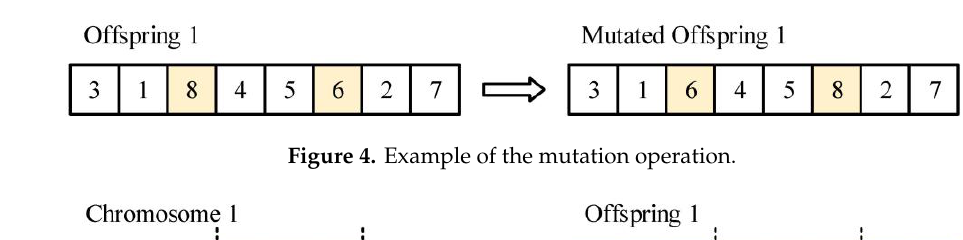
Figure 4. Example of the crossover operation.